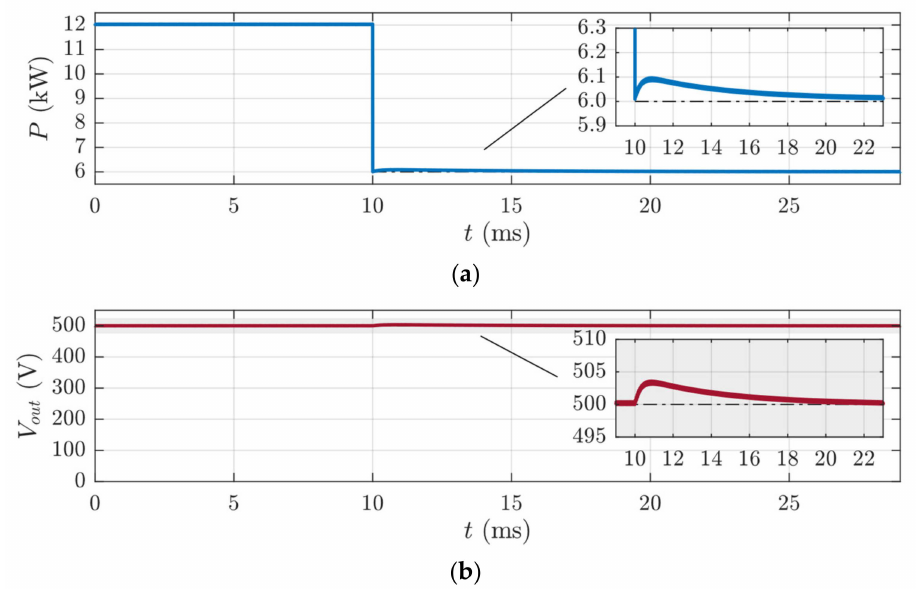
Figure 13. Output power ( a ) and output voltage ( b ) change on the DC bus when load changes from 12 kW to 6 kW in comparison with the same parameters of the comparative article